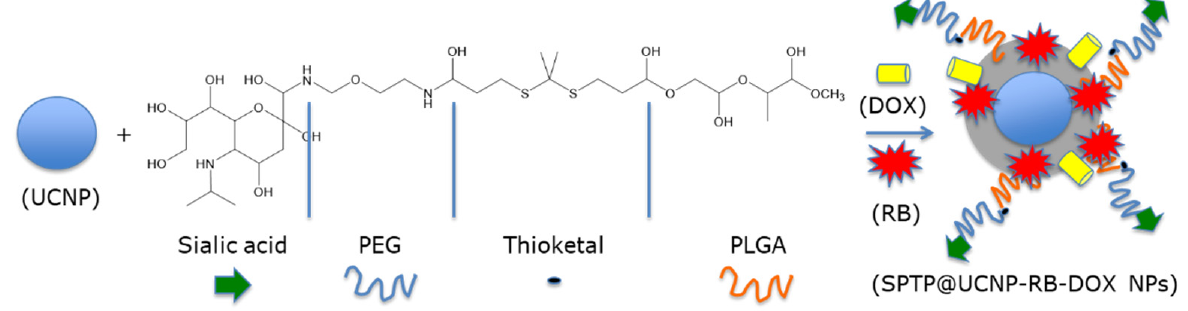
Figure 20. Illustration of the synthesis of the SPTP@UCNP-RB-DOX NPs. Adapted from Jin et al. [42].